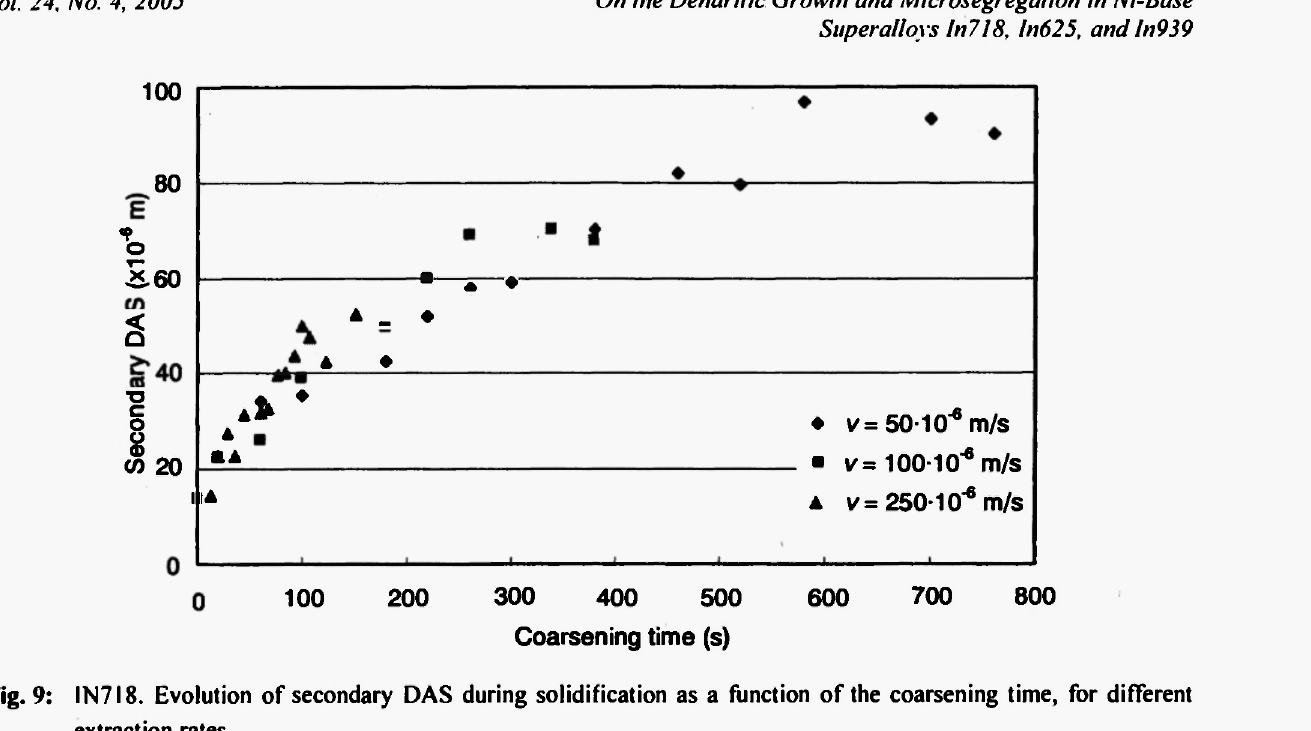
Fig. 9: IN7I8. Evolution of secondary DAS during solidification as a function of the coarsening time, for different extraction rates.